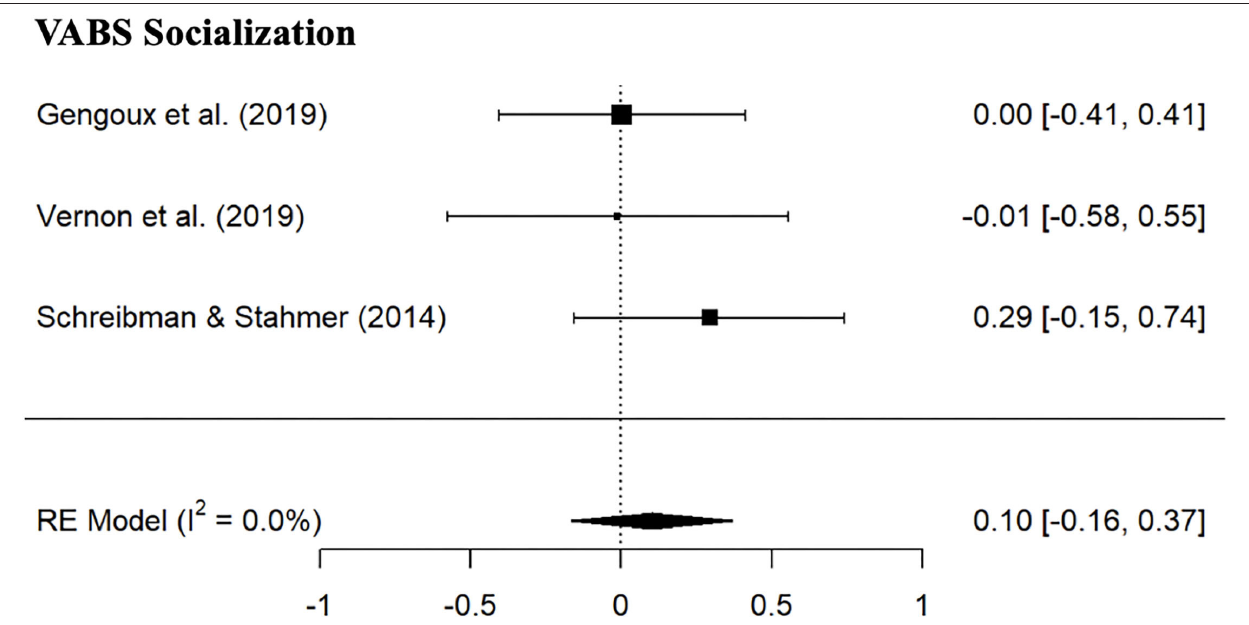
FIGURE 3 | Forest plot of estimates for PRT effects for Vineland Socialization Standard